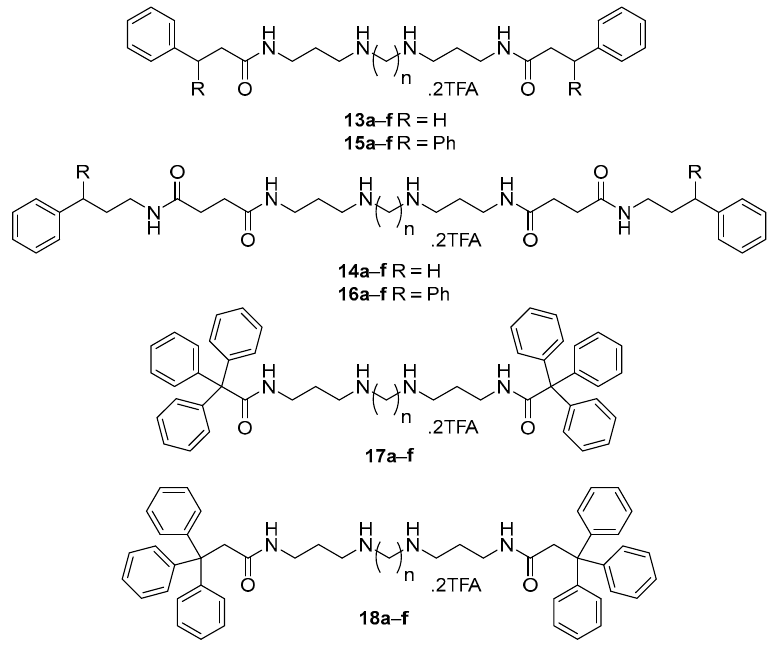
Figure 5. Diacylpolyamines 13a – f to 18a – f .